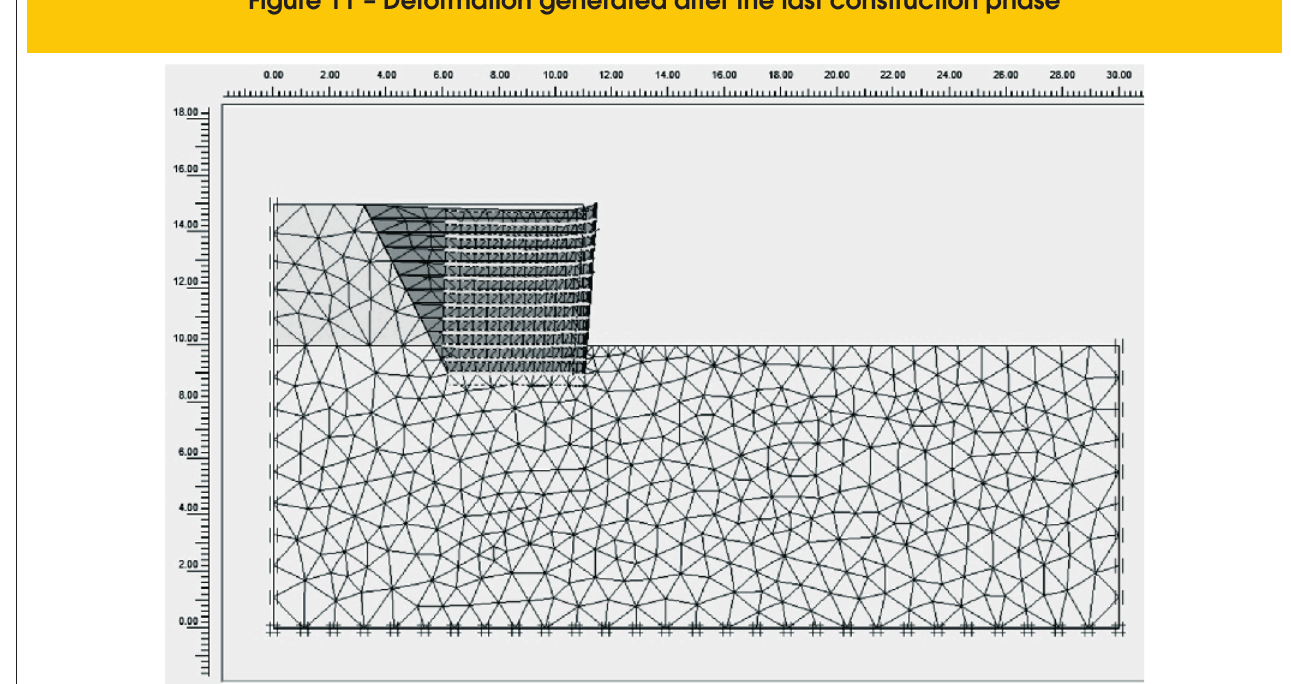
Figure 11 – Deformation generated after the last construction